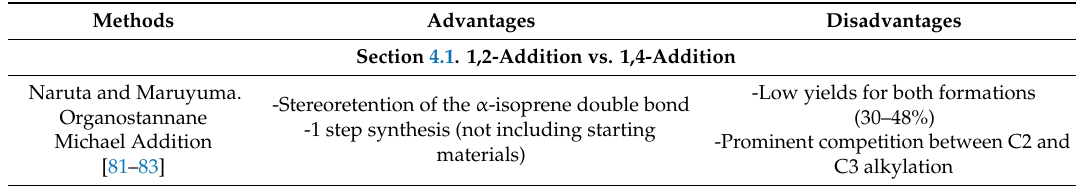
Table 7. Summary of electrophilic ring